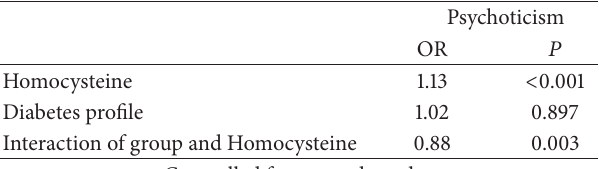
Table 2: Estimates of the binomial generalized linear model for the psychoticism scale of